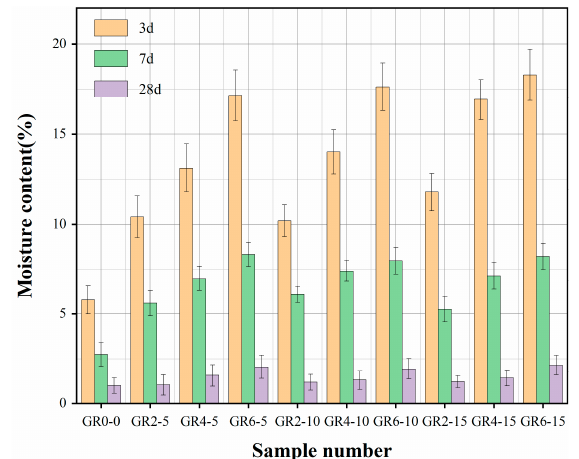
Figure 4. Moisture content of different types of samples . Note: GR2-5 is the abbreviation for a certain mortar sample in which 2 means that the fiber content of the mortar sample is 2%, and 5 means that the length of the fiber in the mortar sample is 5 mm. The abbreviations for other types of mortar samples have similar meaning.